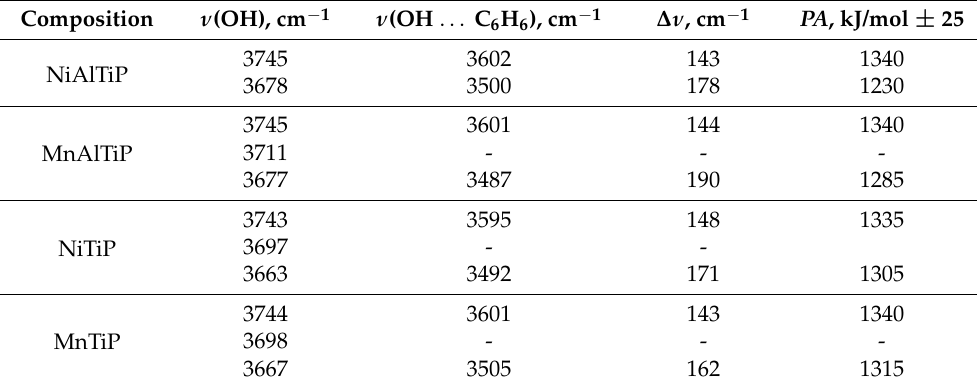
Table 3. Acidic characteristics of the